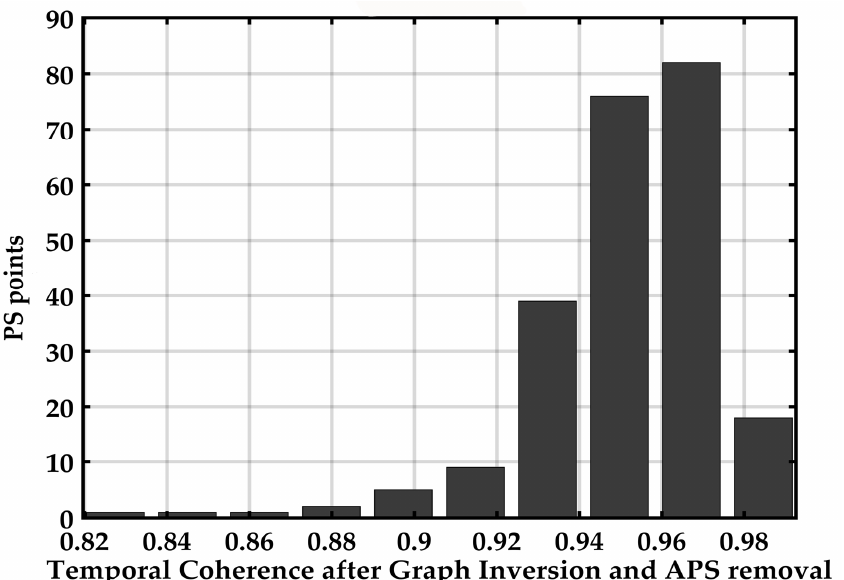
Figure 10. Temporal coherence histogram after atmospheric phase screen removal (example of descending VV data).